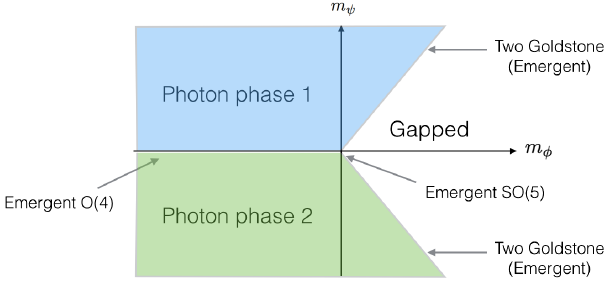
FIG. 4. Phase diagram near the SO(5)-invariant fixed point with perturbation of the form m ϕ ϕ 2 þ m ψ ð ¯ ψ 1 ψ 1 − ¯ ψ 2 ψ 2 Þ . This is